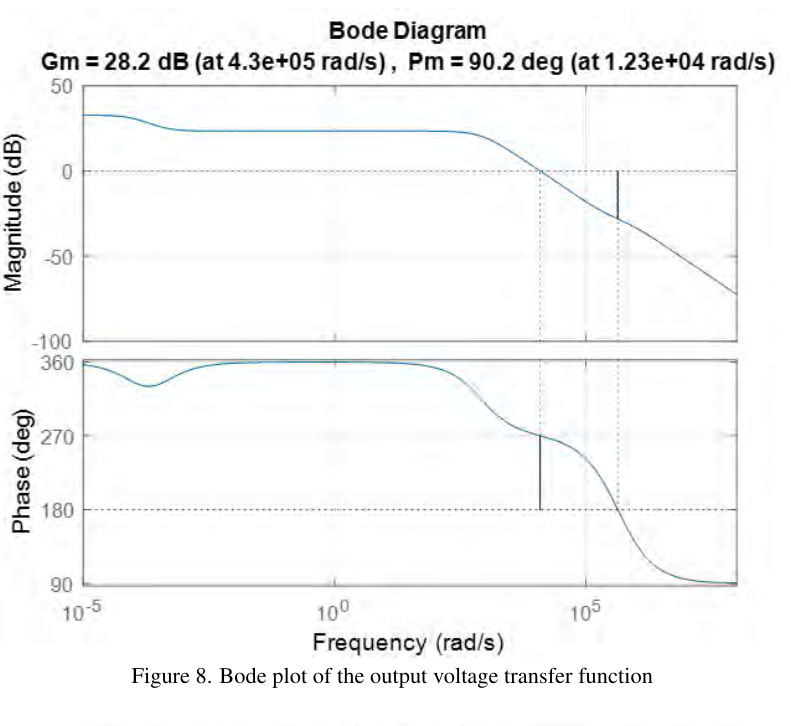
Figure 8. Bode plot of the output voltage transfer function